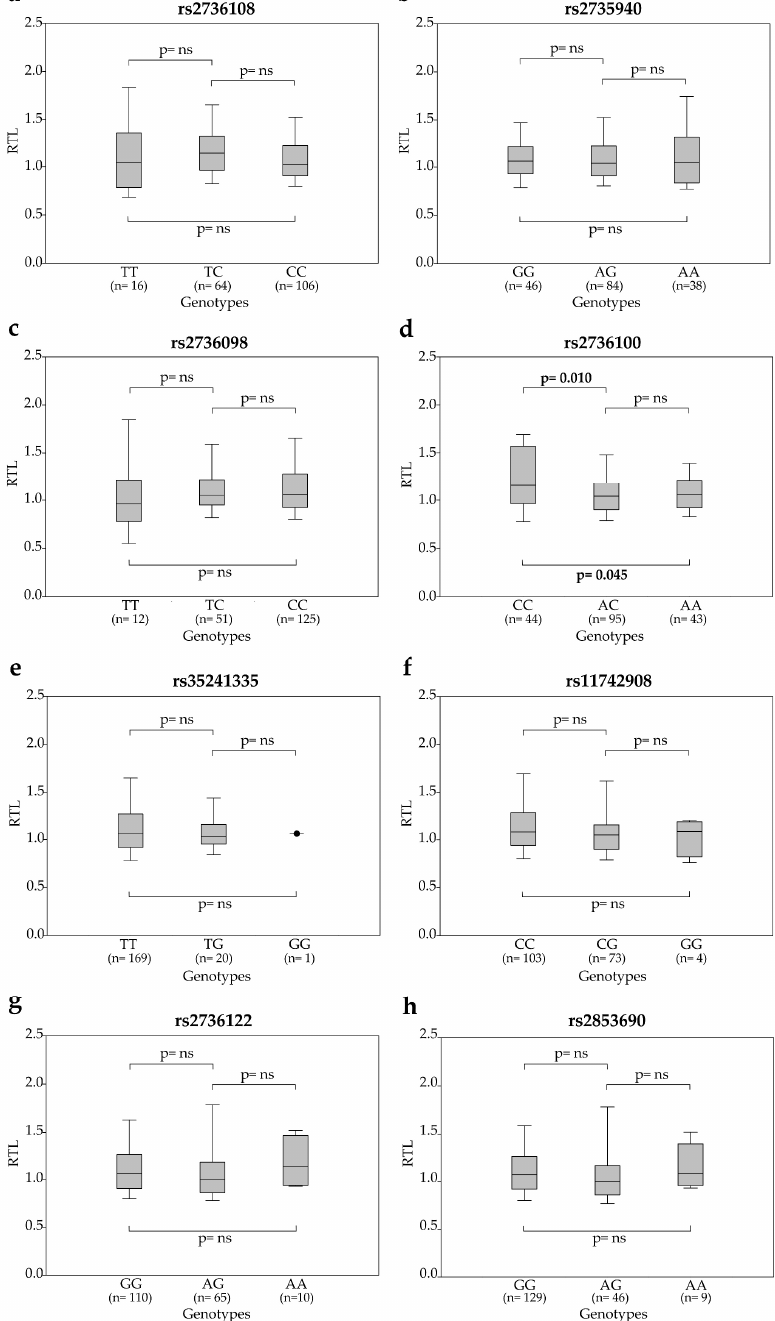
Figure 2. Relative telomere length (RTL) at T0 according to SNP genotypes: ( a ) rs2736108, ( b ) rs2735940, ( c ) rs2736098, ( d ) rs2736100, ( e ) rs35241335, ( f ) rs11742908, ( g ) rs2736122 and ( h ) rs2853690. Boxes and whiskers: 25–75th and 10–90th percentiles, respectively; central line in boxes: